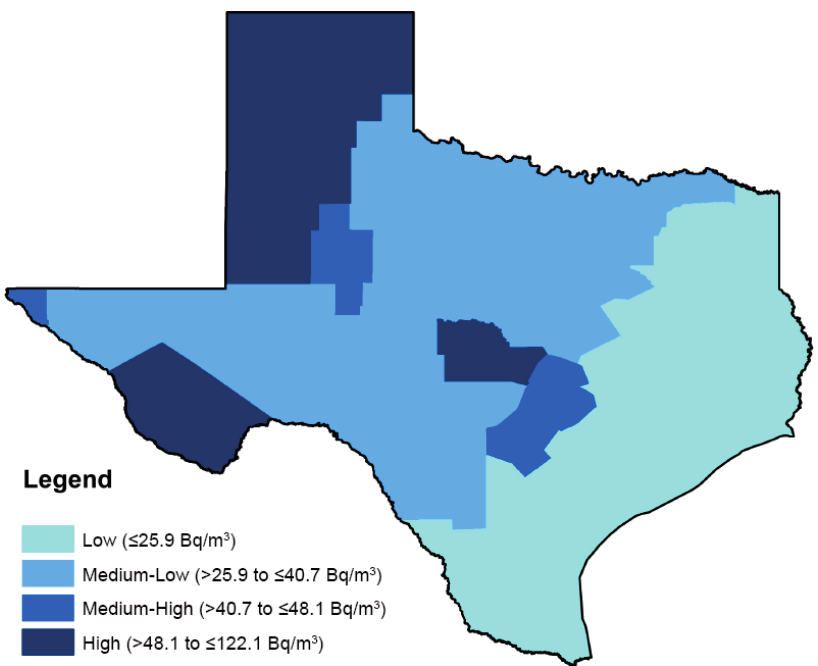
Figure 1. Quartile distribution of residential radon exposure from The Texas Indoor Radon Survey, 1991.